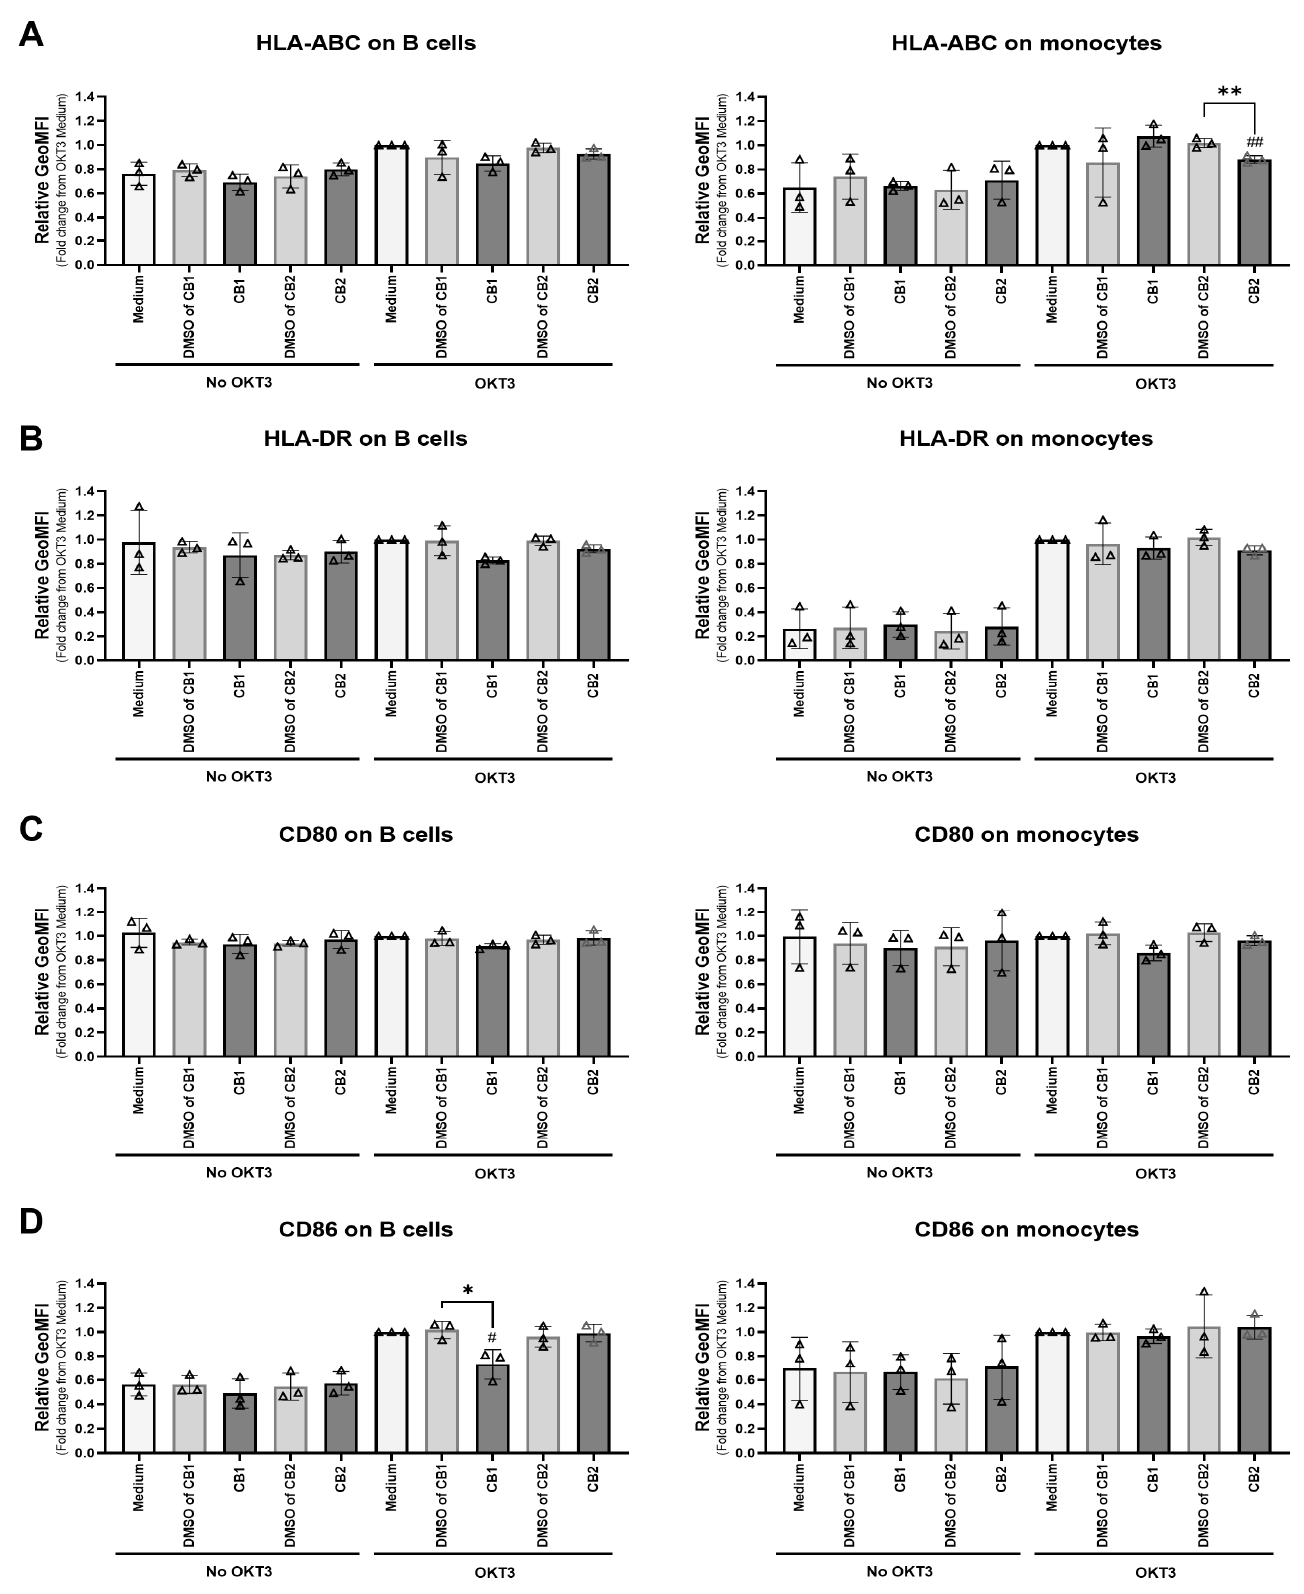
Figure 4. Different effects of CB1 and CB2 agonists on co-stimulatory molecules expressed on B cells and monocytes. PBMCs were stimulated with or without anti-CD3 mAb in the presence of 20 µ M CB1 agonist ACEA or 5 µ M CB2 agonists GW833972A and the results compared with those of the relevant concentrations of DMSO or medium control for 18 h. The surface expression levels of